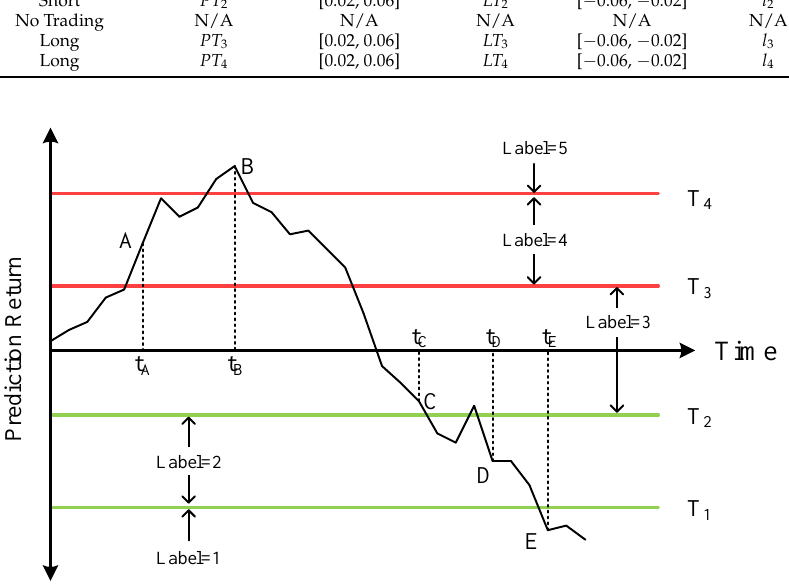
Figure 3. The multiclassification examples of the proposed method.